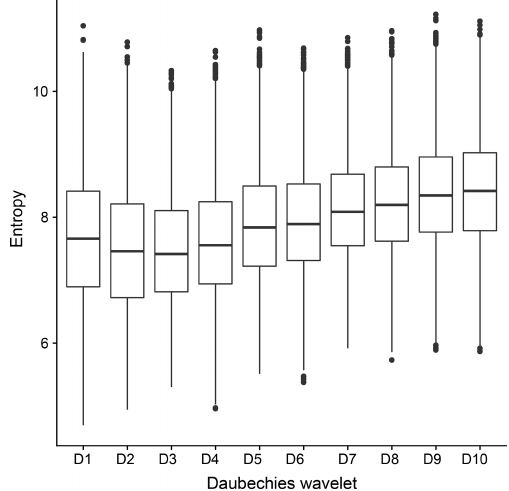
Figure A1. Entropy of the transforms for the first 10 Daubechies wavelets (specifically the “extremal phase” versions). Points denote the median, lines the interquartile range over all forecasts and ob- servations from our data